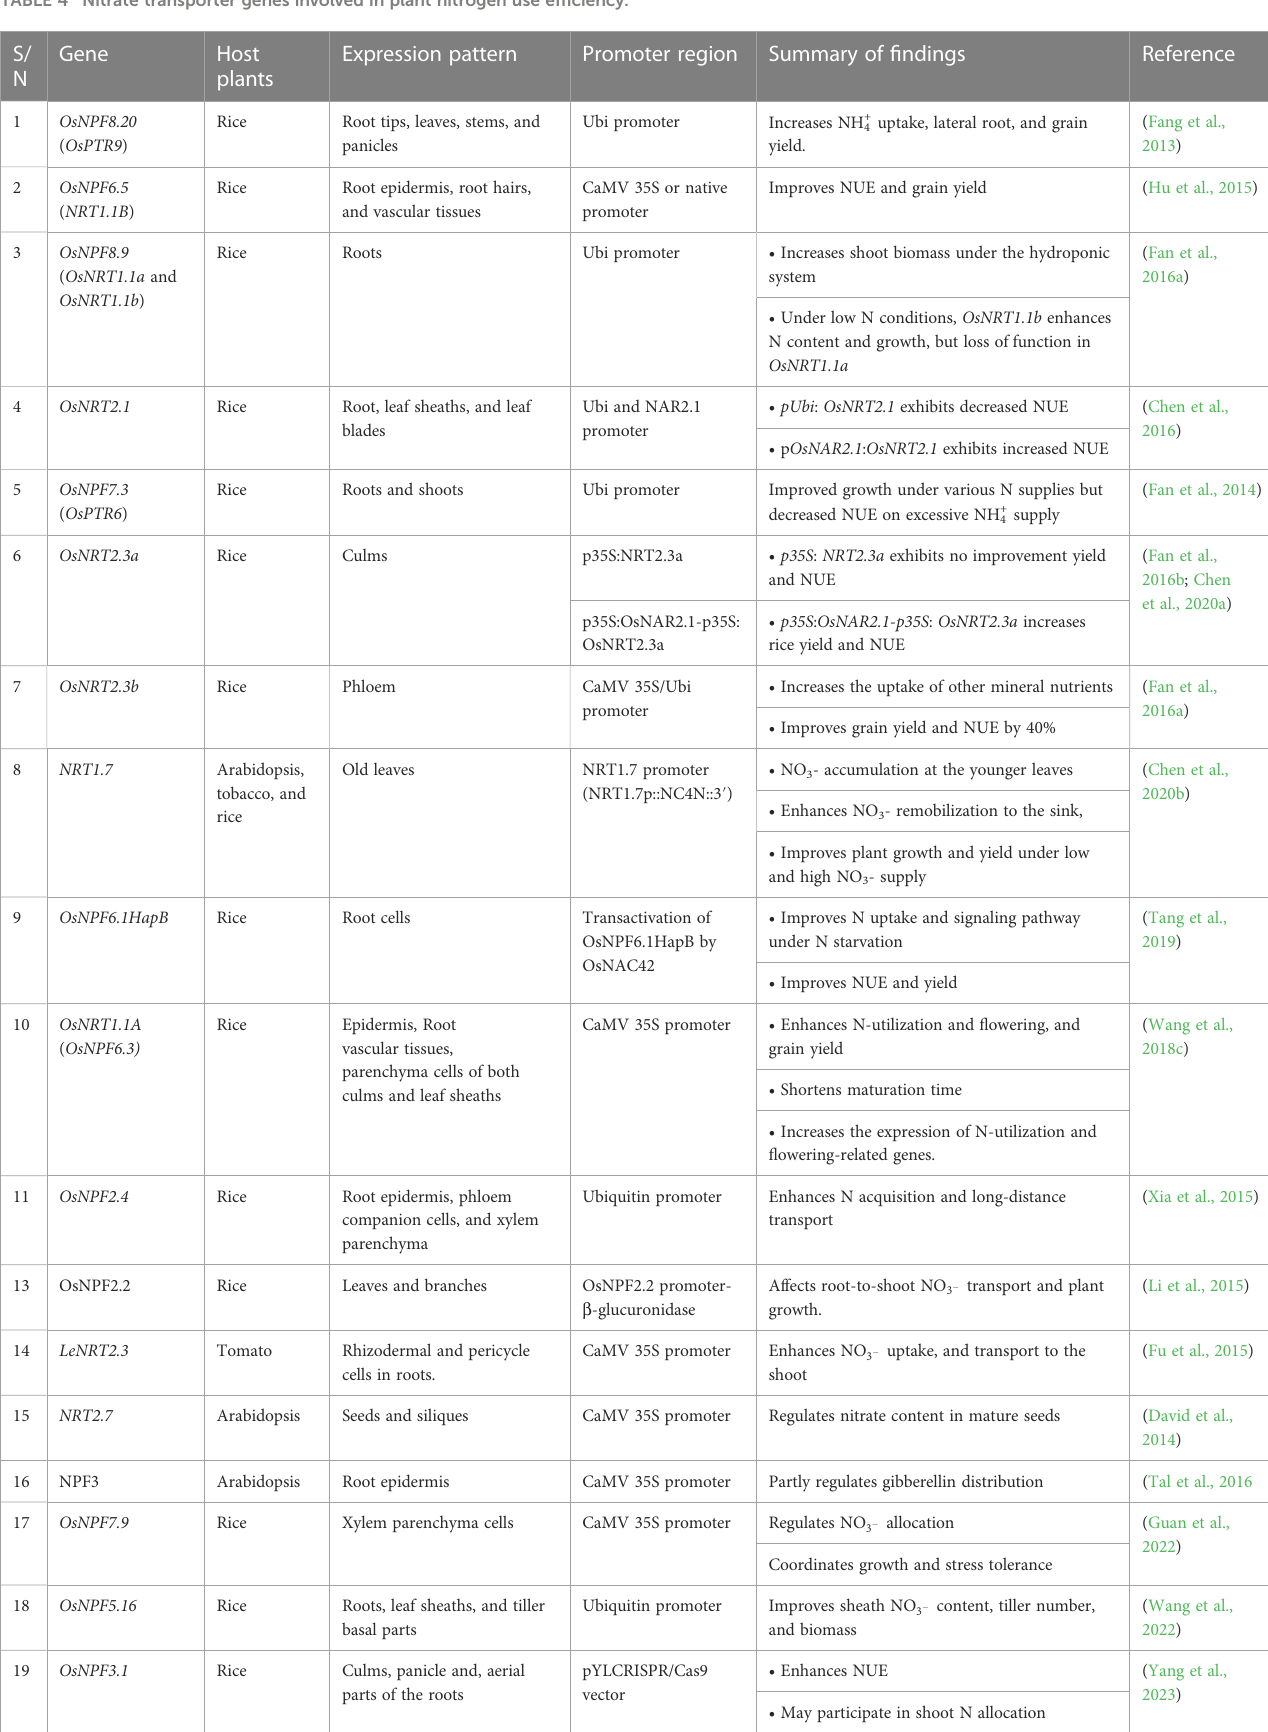
TABLE 4 Nitrate transporter genes involved in plant nitrogen use ef fi